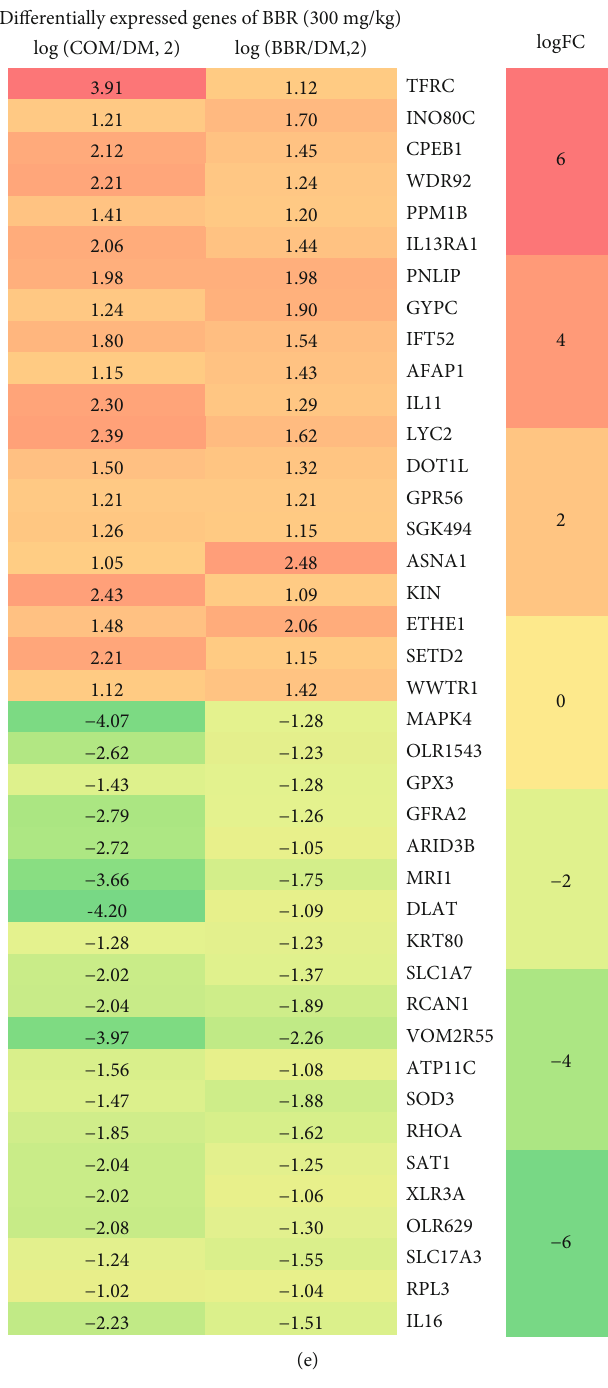
Figure 3: Volcano plot of gene expression pro fi le data between the (a) model and normal samples, (b) BBR (150mg/kg) and model groups, and (c) BBR (300mg/kg) and model groups. Heat map of DEGs in (d) BBR (150mg/kg) and (e) BBR (300mg/kg). Green represents a lower fold change value; red represents a higher fold change value. Each column represents one dataset, and each row represents one gene. The number in each rectangle represents fold change in the BBR compared with the control samples or the control samples compared with the model samples. The gradual color that ranged from red to green represents the changing process from upregulation to